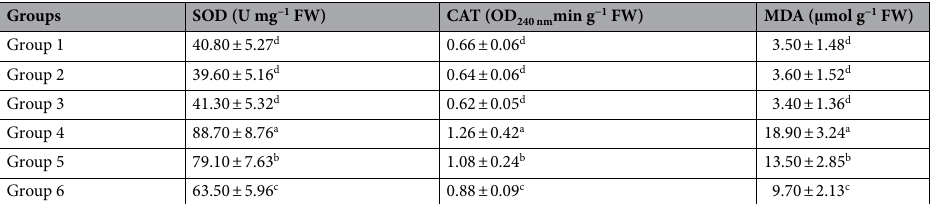
Table 4. Biochemical changes caused by diniconazole and CME. *Data are shown as mean ± SD (n = 10). Group 1: control, Group 2: 0.5 g/L CME, Group 3: 1.0 g/L CME, Group 4: 100 mg/L diniconazole, Group 5: 0.5 g/L CME + 100 mg/L diniconazole, Group 6: 1.0 g/L CME + 100 mg/L diniconazole. SOD superoxide dismutase, CAT catalase, MDA malondialdehyde. The averages shown with different letters (a–d) in the same column are statistically significant (p <